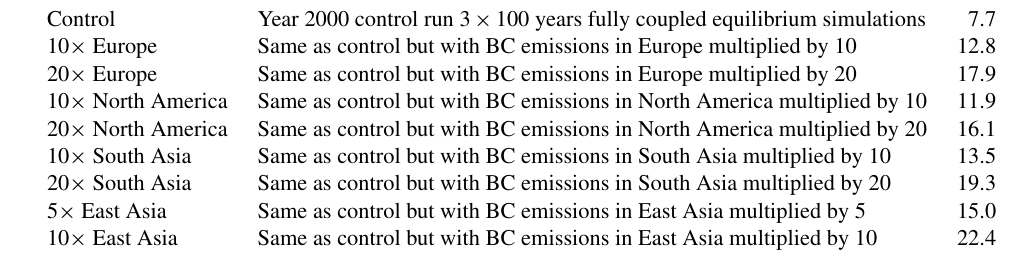
Table 1. Overview of the model simulations in this study and the global BC emissions in each simulation (in TgBCyr − 1 ). Control Same as control but with BC emissions in Europe multiplied by 20 10 × North America Same as control but with BC emissions in North America multiplied by 10 20 × North America Same as control but with BC emissions in North America multiplied by 20 10 × South Asia Same as control but with BC emissions in South Asia multiplied by 10 20 × South Asia Same as control but with BC emissions in South Asia multiplied by 20 5 × East Asia Same as control but with BC emissions in East Asia multiplied by 5 10 × East Asia Same as control but with BC emissions in East Asia multiplied by 10